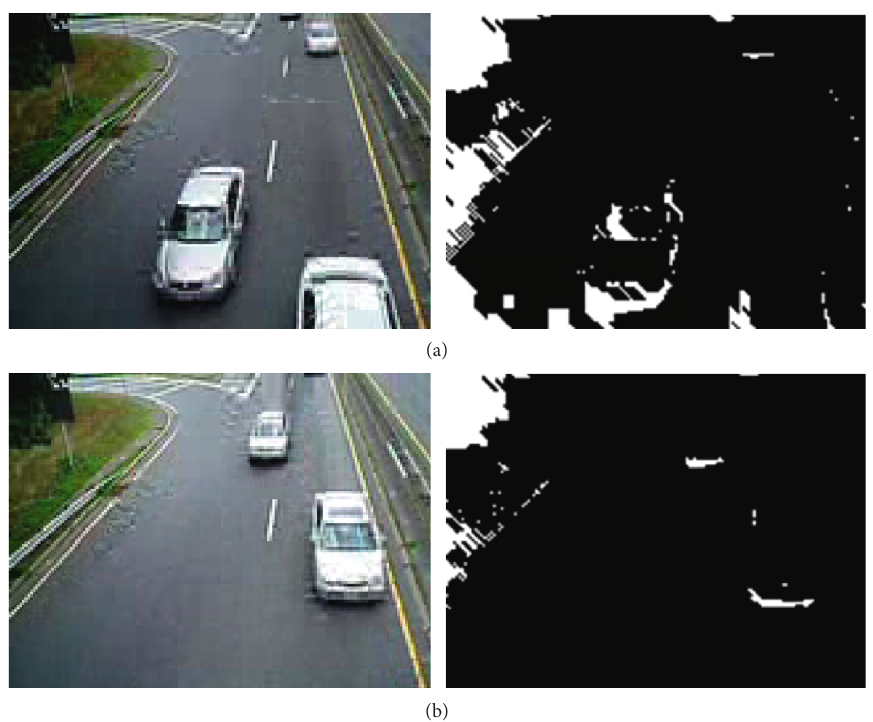
Figure 5: Shadow detection results based on HSV color space. (a) Frame #12. (b) Frame